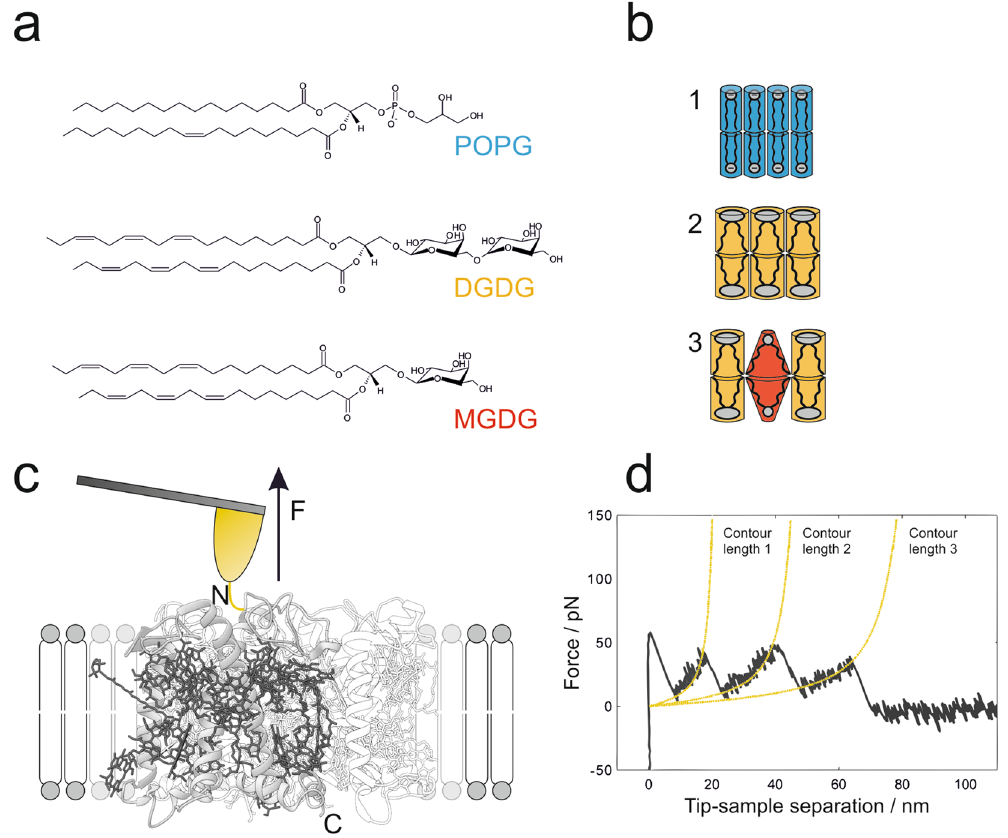
Figure 1. Mechanical unfolding of LHCII in membranes assembled from thylakoid lipids. ( a ) Chemical structures of model phospholipid POPG and thylakoid glycolipids DGDG and MGDG. ( b ) Lipid geometries corresponding to ( a ) and lipid compositions of the membranes applied for unfolding experiments (1–3). The degree of saturation in the alkyl chain region and the size of the head group determine the shape of lipids. Hence, POPG (blue) and DGDG (orange) adopt a cylindrical shape, forming lamellar membranes (1,2). Due to its conical shape the non-bilayer lipid MGDG (red) causes alterations in the lateral pressure profile upon incorporation into lamellar membranes 23, 24 ; here: lipid ratio of DGDG / MGDG = 2:1 (3). ( c ) Schematic representation of SMFS with LHCII embedded in lipid bilayers with compositions according to ( b ). Site- directed unfolding of LHCII is achieved by covalently attaching a gold-coated AFM tip to a cysteine motif (yellow) at the amino-terminus N of the polypeptide. Retraction of the tip applies a pulling force F to LHCII monomers, which get extracted from the membrane out of their trimeric assembly (transparent presentation), thereby inducing stepwise unfolding of the protein; gray: polypeptide, dark grey: pigments (obtained with Chimera and PDB ID code 2BHW). ( d ) Exemplary force-distance curve recorded during the unfolding process described in ( c ). Each force peak, representing an unfolding event of LHCII, is fitted with the WLC model (yellow) which provides information about the positions of the stabilized domains (contour lengths) and the forces needed to overcome these barriers along the LHCII